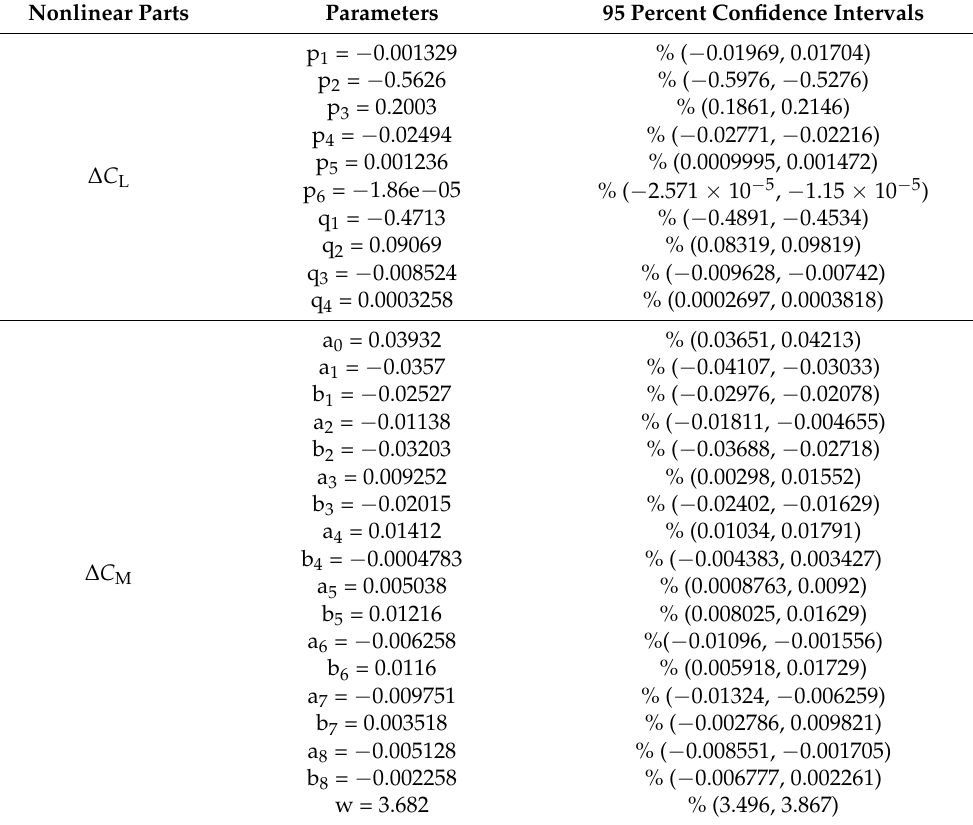
Table 2. The related parameters in Equations (18) and (19). Nonlinear